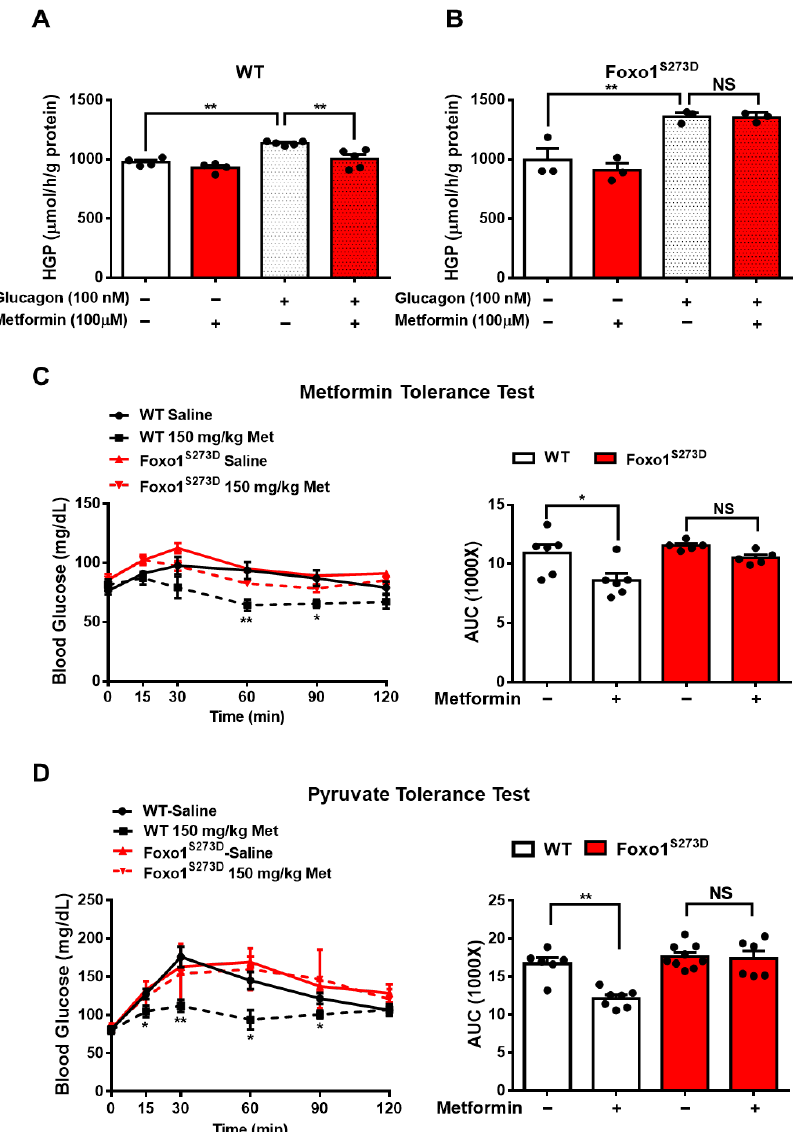
Figure 3. Foxo1-S273D mutation blocks metformin-induced HGP and blood glucose suppression in mice. ( A , B ) Primary hepatocytes isolated from WT ( A ) and Foxo1 S273D ( B ) mice were pretreated with 100 µ M of metformin for 30 min and then treated with 100 nM of glucagon for 3 h. Glucose content was measured, n = 3–4 independent experiments/group. ( C ) 150 mg/kg body weight metformin (Met) was acutely i.p. injected into 16 h fasting WT and Foxo1 S273D mice. Blood glucose was monitored at indicated time points, n = 5–6 mice/group. ( D ) WT and Foxo1 S273D mice were fasted for 16 h and then i.p. injected with 150 mg/kg body weight metformin. After 45 min, pyruvate tolerance test was performed, n = 6–9 mice/group. All data are presented as mean ± SEM. * p < 0.05, ** p < 0.01, NS: no significance.